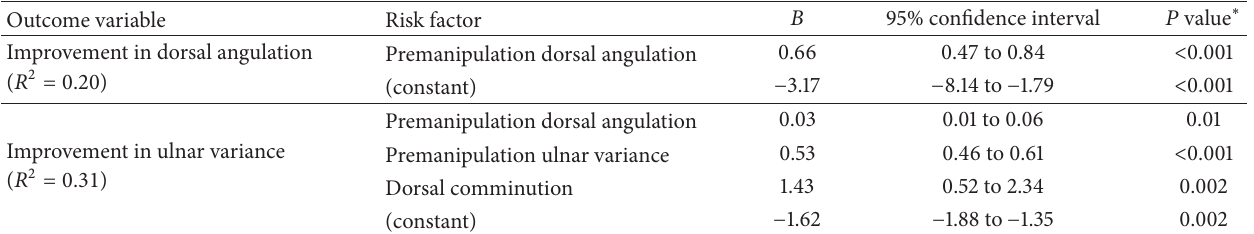
Table 4: Significant predictors of improvement in dorsal angulation and ulna variance at 6